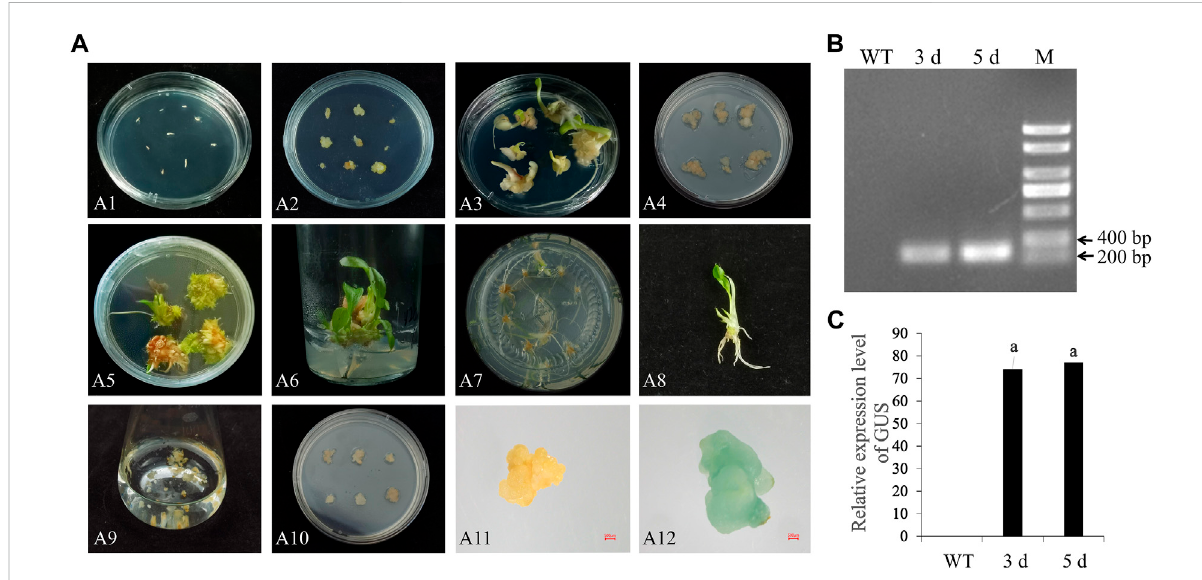
FIGURE 4 Somatic embryo induction and genetic transformation of calla lily. (A) A1: Seed embryo inoculation; A2: Seed embryo germination; A3: Seed embryo produces callus; A4: Callus propagation; A5: Callus germination; A6: Elongation; A7: Take root culture; A8: Intact plant; A9: Infect; A10: Co- culture; A11: GUS staining control group; A12: GUS staining test group; Scale bars, 500 μ m. (B) Identi fi cation of transformation effect by PCR of the GUS fragment, and M represents the DNA marker (C) Identi fi cation of GUS expression in transformed callus.